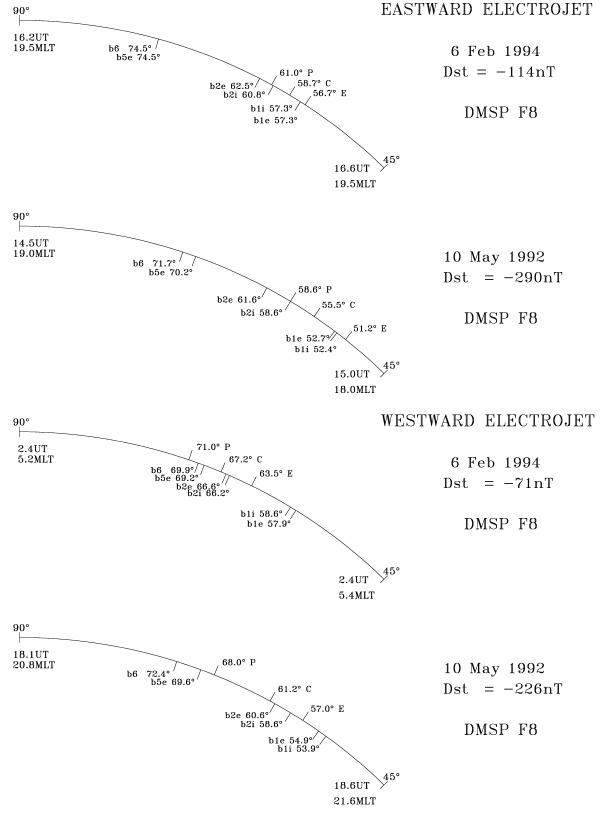
Fig. 9. Comparison of the location of auroral electrojets (their po- lar, P, and equatorial, E, boundaries, and centre, C) and particle precipitation boundaries (b1e, b1i, b2i, b2e, b5e, and b6) during the moderate (6 February 1994) and severe (10 May 1992) magnetic storms: the eastward (first and second panels) and westward (third and forth panels) electrojets. Corresponding UT and MLT for the electrojets according to IMAGE chain are indicated to the left and those for the precipitation boundaries during the DMSP F8 passes over electrojets are indicated to the right (each panel). The latitu- dinal range considered is 45 ◦ –90 ◦ CG latitude. Hourly D st values correspond to a given